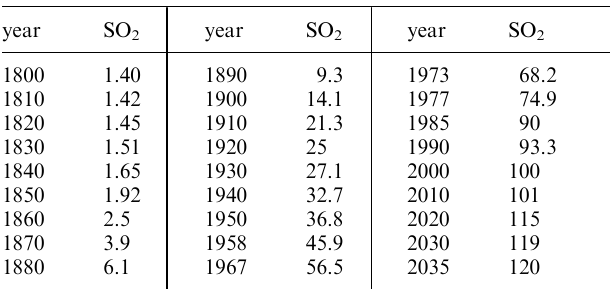
concentration (ppmv) 2